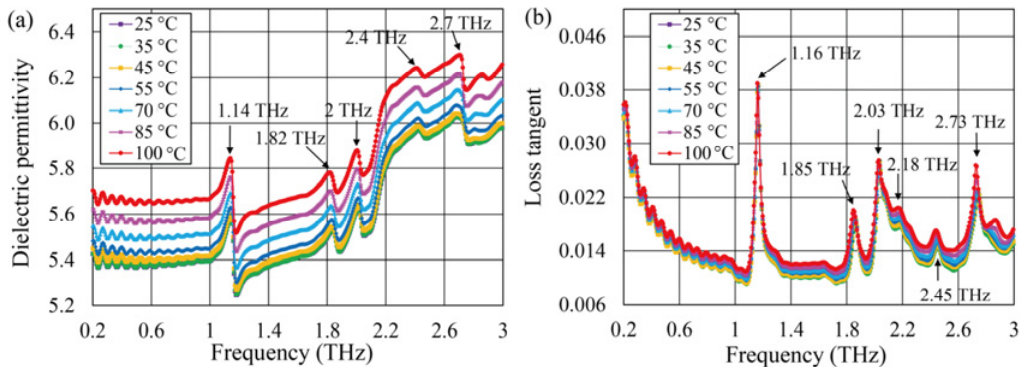
Fig. 12 Dielectric permittivity (a) and loss tangent (b) versus frequency in the range of 0.2–3 THz at 20 ℃ for Li 2 WO 4 ceramics doped with 4% CuBi 2 O 4 , sintered at 600 ℃